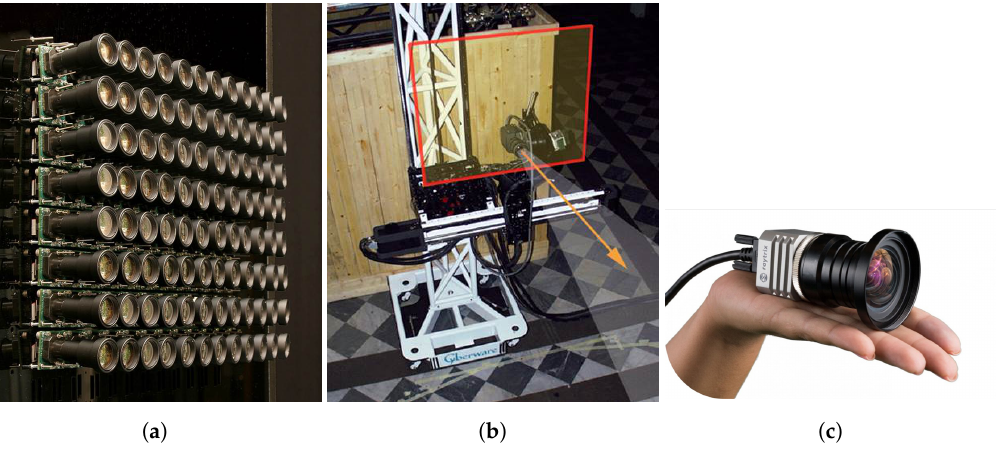
Figure 3. Examples of different implementations of light-field capturing devices: ( a ) camera rig mounting an array of eight by twelve cameras; ( b ) moving gantry shifting the camera in the area indicated by the red square; ( c ) plenoptic camera by Raytrix (image from